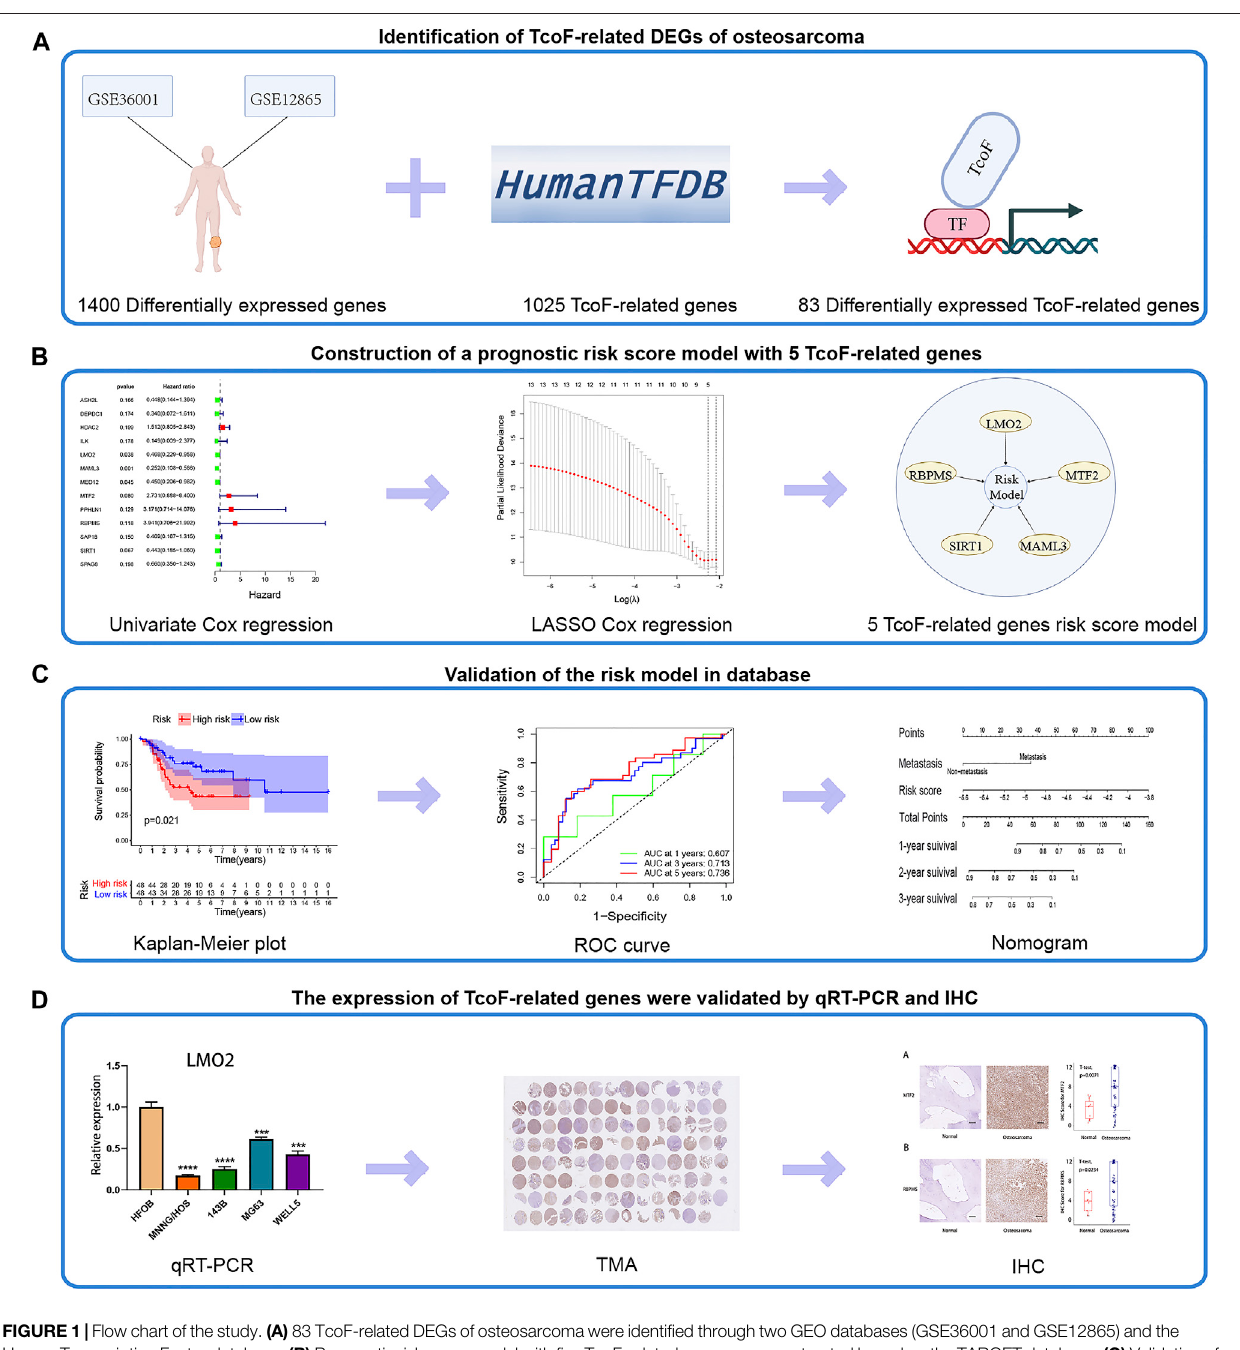
Frontiers in Genetics |